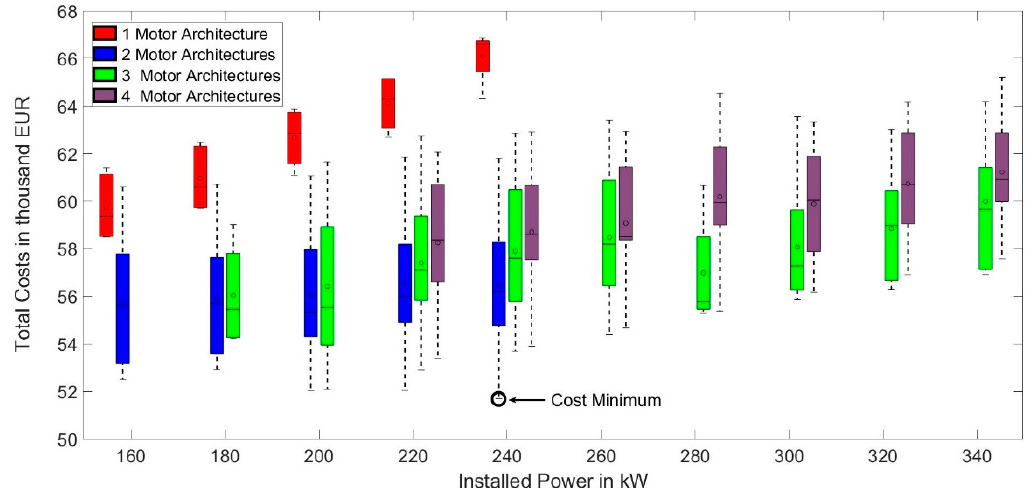
Figure 9. Cost dependency of installed power for different powertrain architectures.